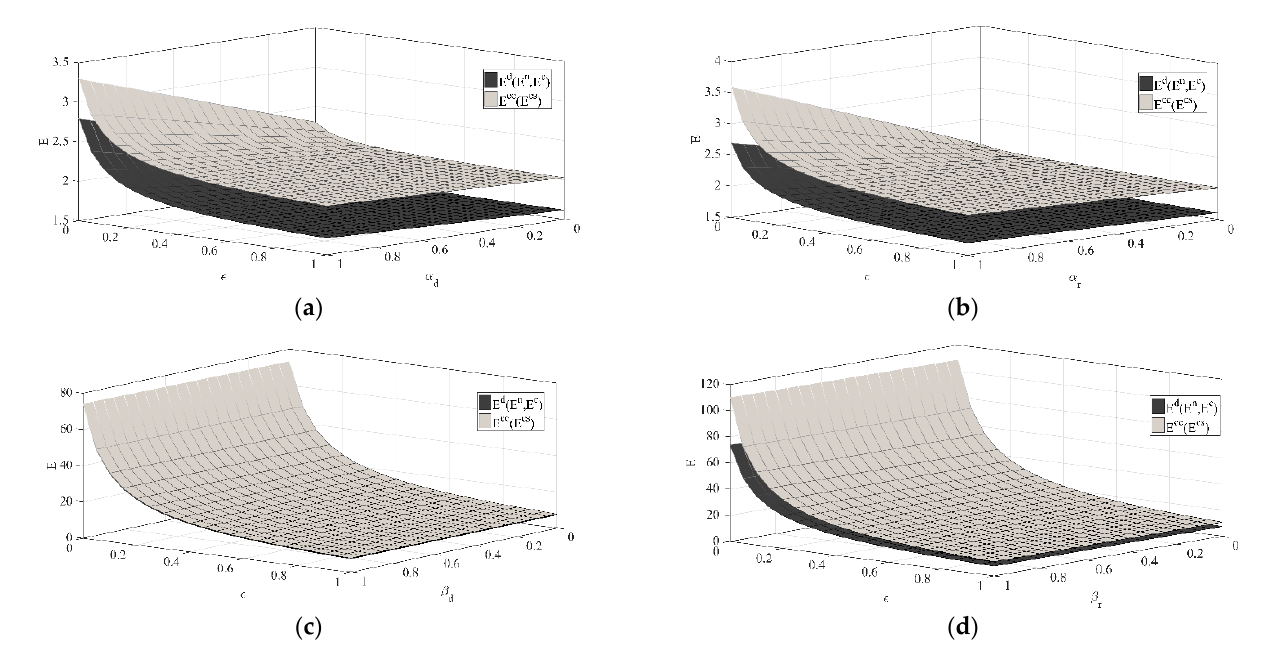
Figure 4. The impact of effectiveness parameters on the manufacturer’s emission reduction investment. ( a ) The effect of α r and ε . ( b ) The effect of α d and ε . ( c ) The effect of β r and ε . ( d ) The effect of β d and ε